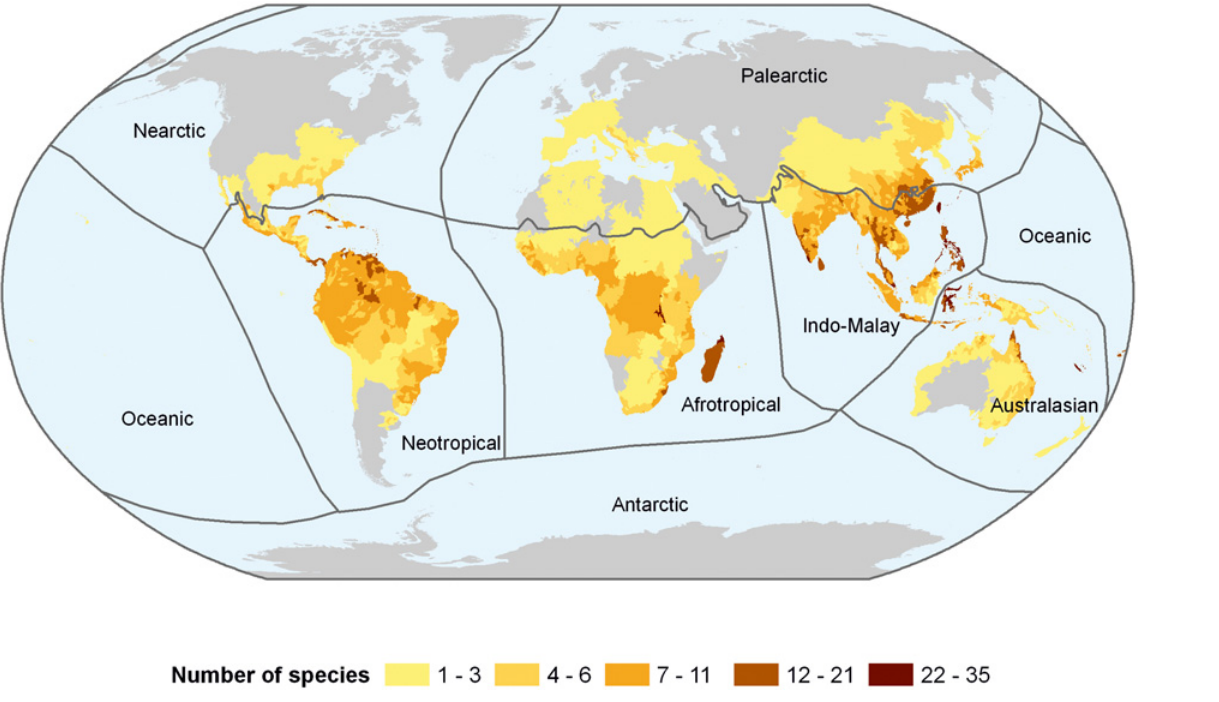
Fig 3. Global species richness of freshwater shrimps, based on 713 out of 763 species. doi:10.1371/journal.pone.0120198.g003 third (37.0%) of freshwater shrimps suffer from a relative paucity of data and are assessed as Data Deficient. Different levels of extinction risk are apparent (Fig. 5) at family level, with the extinction risk of Atyidae (37% species threatened) being more than twice that of the other speciose family, Palaemo- nidae (14.8%). Desmocarididae and Typhlocarididae are highly threatened (50.0 and 100.0% respec- tively), as are the freshwater members of Alpheidae (60.0%). The lowest extinction risk currently exists in Xiphocarididae at 0%, with one species being LC and one being DD. Noteworthy is the much higher percentage of DD species in Atyidae (42.4%) compared to Palaemonidae (28.6%). On the basis of biogeographical realms (Table 1), the Nearctic has the highest proportion of threatened species (46.1%), despite harbouring the lowest biodiversity of all realms. The Indo- Malayan region, where over half of global shrimp diversity occurs, has nearly one-third